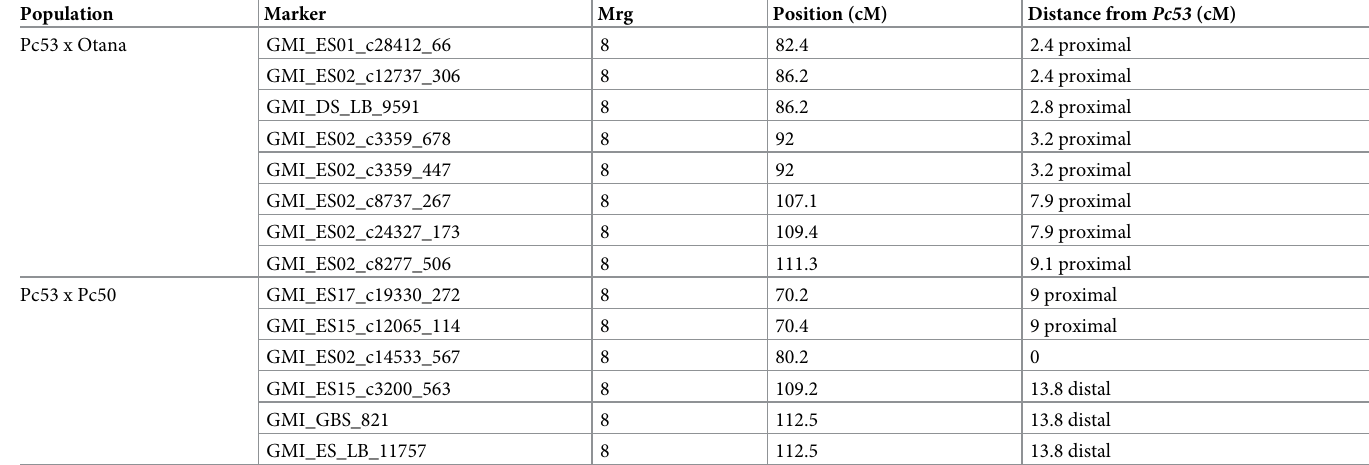
Table 2. Single nucleotide polymorphism markers closely linked with the crown rust resistance gene Pc53 in two oat mapping populations. Mrg groups and posi- tions are based on the consensus map developed by Chaffin et al . [23]. Population